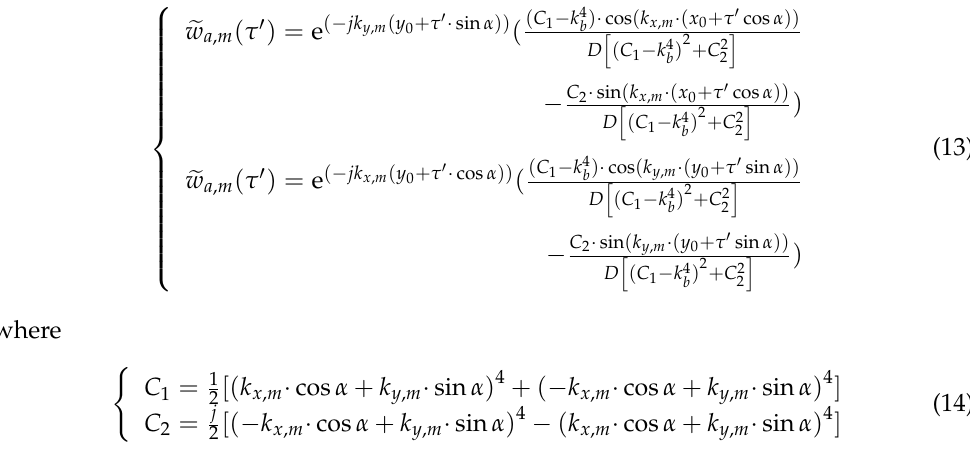
Figure 6. Enveloping rectangle of an irregular shaped acoustic cavity. Corresponding to each acoustic wave function, the cavity sound pressure induced transverse displacement of the plate can be expressed as